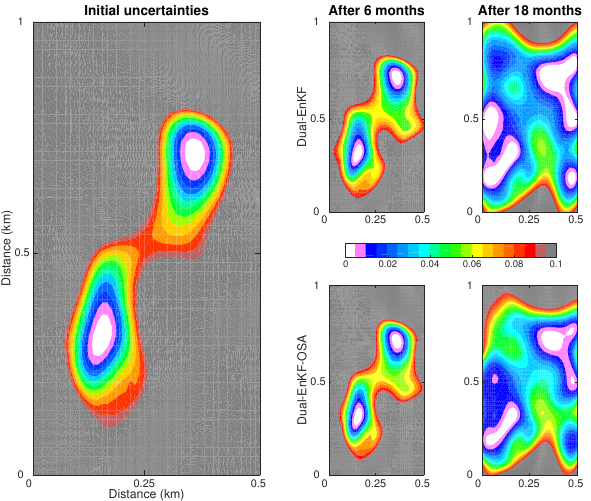
Figure 11. Reference (dashed) and predicted (solid) hydraulic head evolution at the control well: CW. Results are obtained using the joint EnKF, dual EnKF, and the dual EnKF OSA schemes with 100 members, 1 day as sampling period, 25 observation wells, and 0.50m of measurement noise. The last 18 months are purely based on the forecast model prediction with no assimilation of data. In the bottom-right subplot, the absolute bias of hydraulic head is eval- uated for all schemes during the prediction phase only (i.e., after 1.5